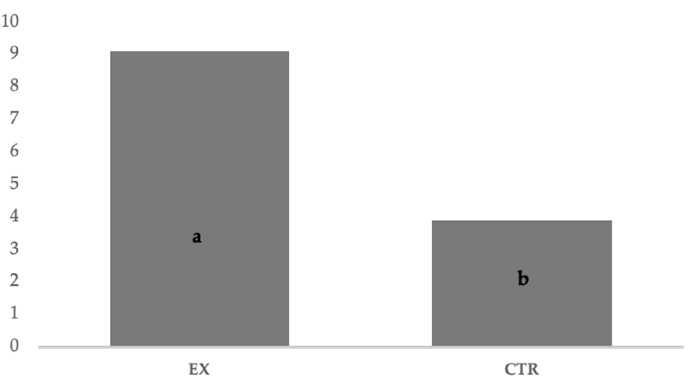
Figure 6. Percentage of fetal resorption recorded by ultrasound checks between two groups. EX: experimental; CTR: control; a, b: p < 0.05 (Wilcoxon non-parametric test).